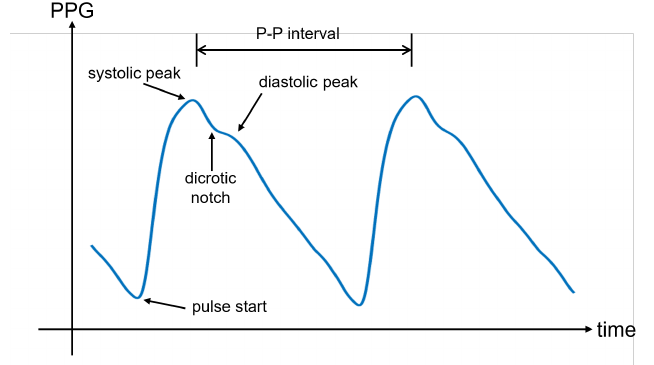
Figure 5. An illustrative PPG wave for one pulse, with the pulse start, systolic, and diastolic peaks, the dicrotic notch, and the pulse to pulse (P-P) interval indicated. The P-P interval is the time between to consecutive systolic peaks. Note that with respect to Figure 4, the signal is flipped along the vertical axis, to represent the volume instead of the detected light